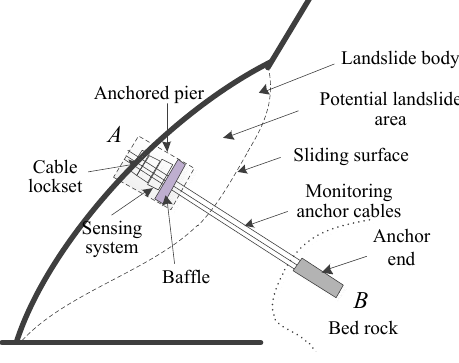
Figure 3. Schematic of the sliding force measuring system in slope engineering.